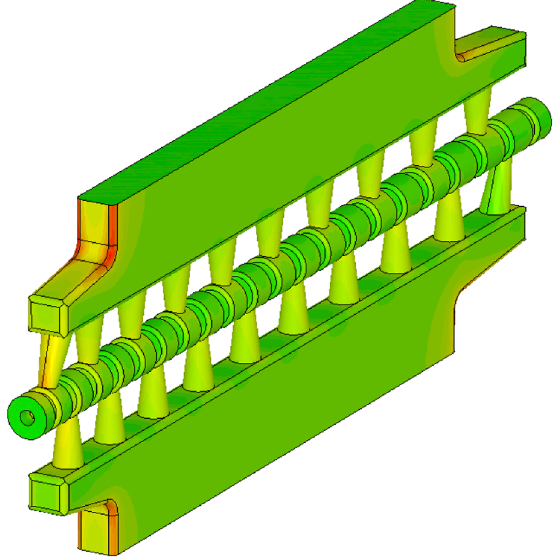
FIG. 14. Surface-current magnitude inside the IH1 tank (the tank outer cylindrical surface is not shown): red color corresponds to the highest value, and dark green to zero.